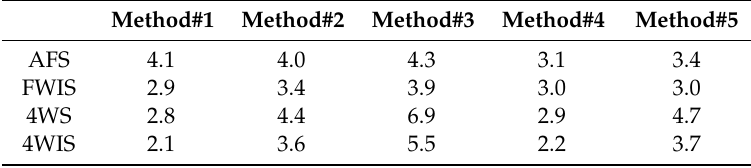
Table 3. Maximum absolute side-slip angle for each actuator and